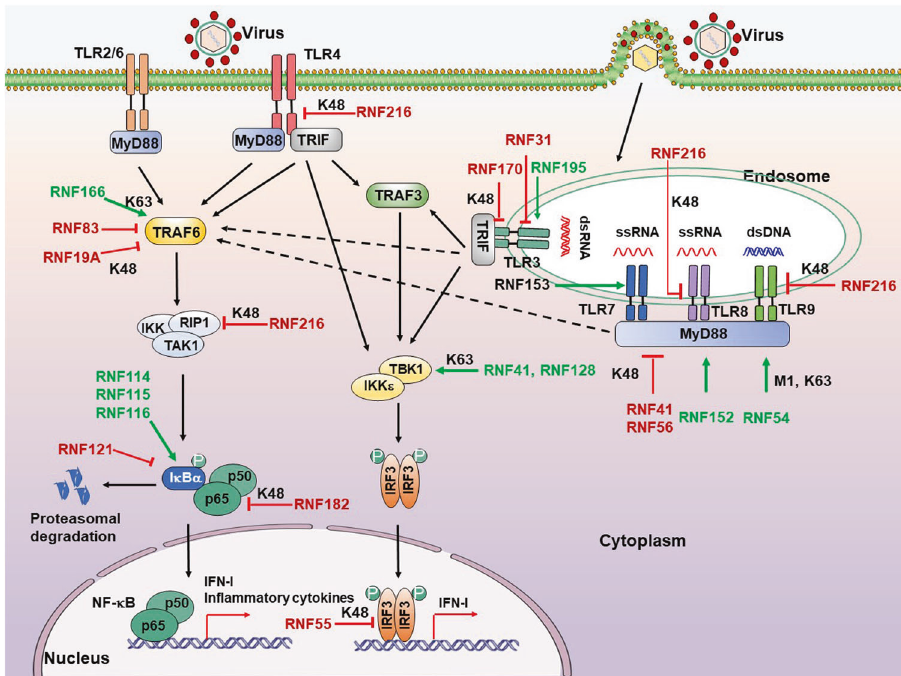
Fig. 2 RNF proteins regulate the TLR signaling pathway. TLRs locate at both plasma membrane and endosomes. TLRs sense different ligands like viral nucleic acids and viral envelope glycoproteins and recruit TRIF and MyD88 to transduce signals, ultimately activating IRFs and NF- κ B to product IFN-I and proin fl ammatory cytokines. RNF proteins positively (green arrows) or negatively (red T-shaped solid line) regulate multiple steps downstream of the TLR signaling pathway. P,